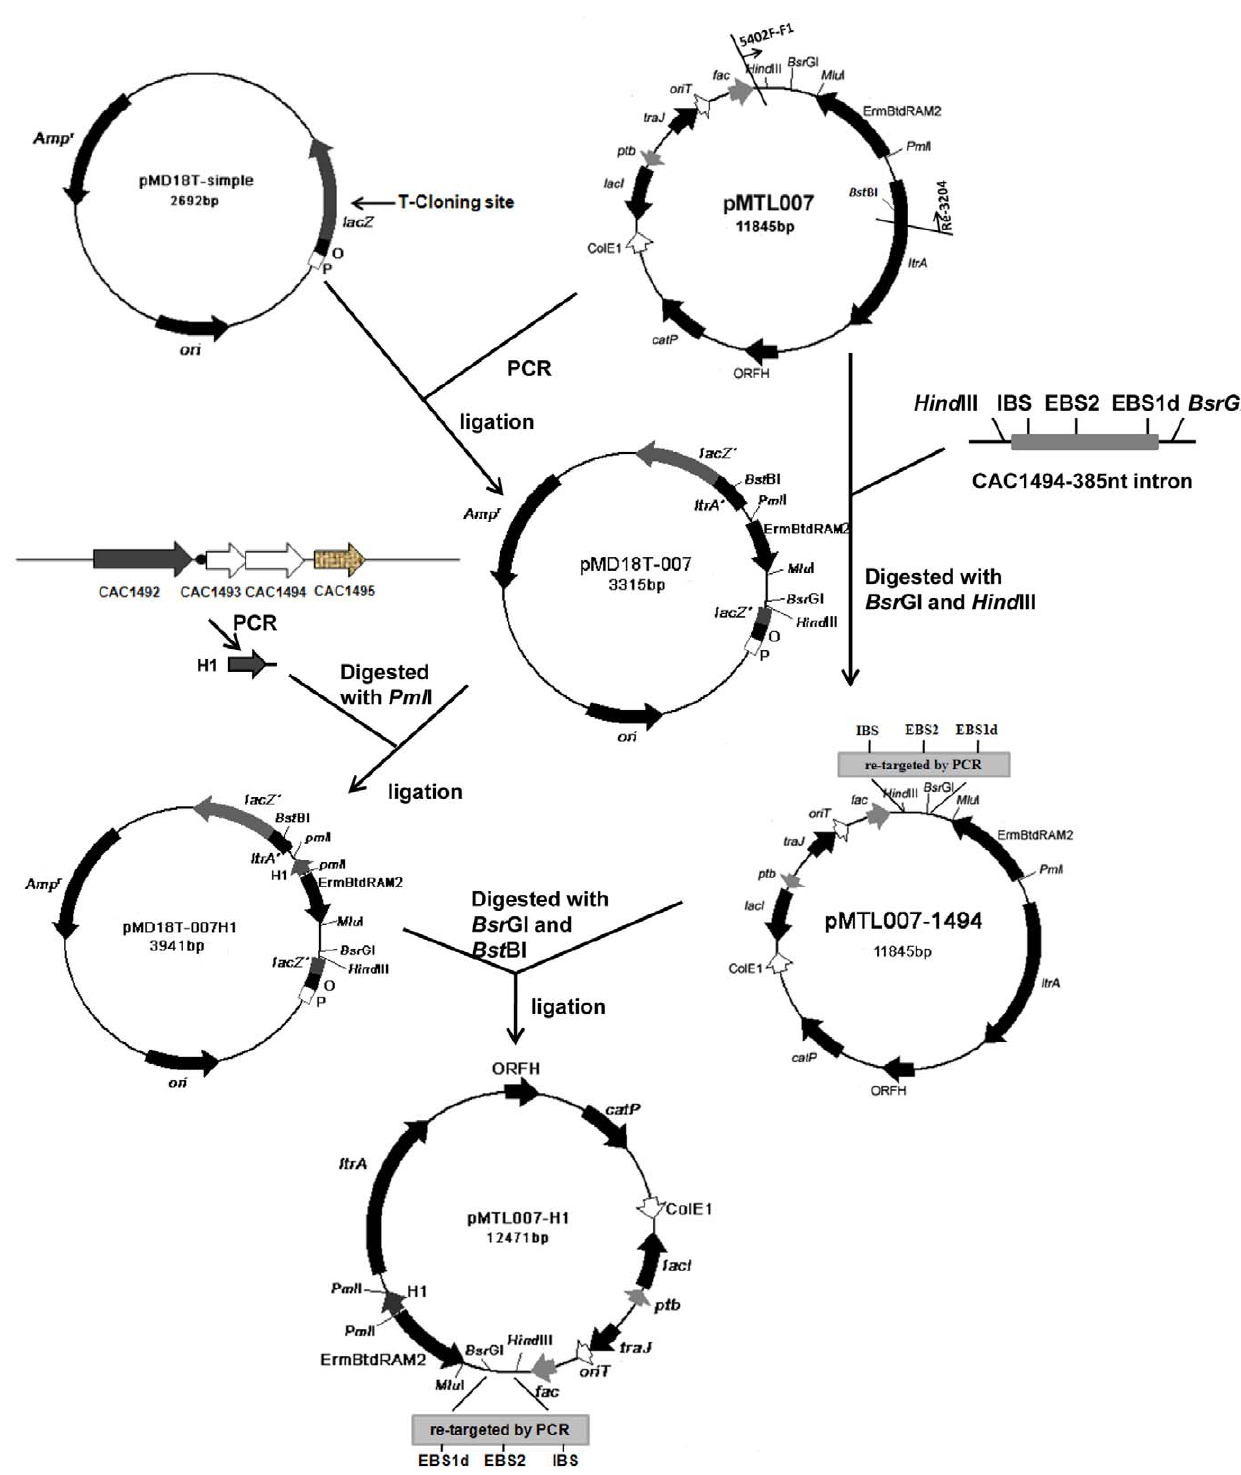
Figure 2. Schematic representation of the construction of pMTL007-H1 for deletion of CAC1493-1494.